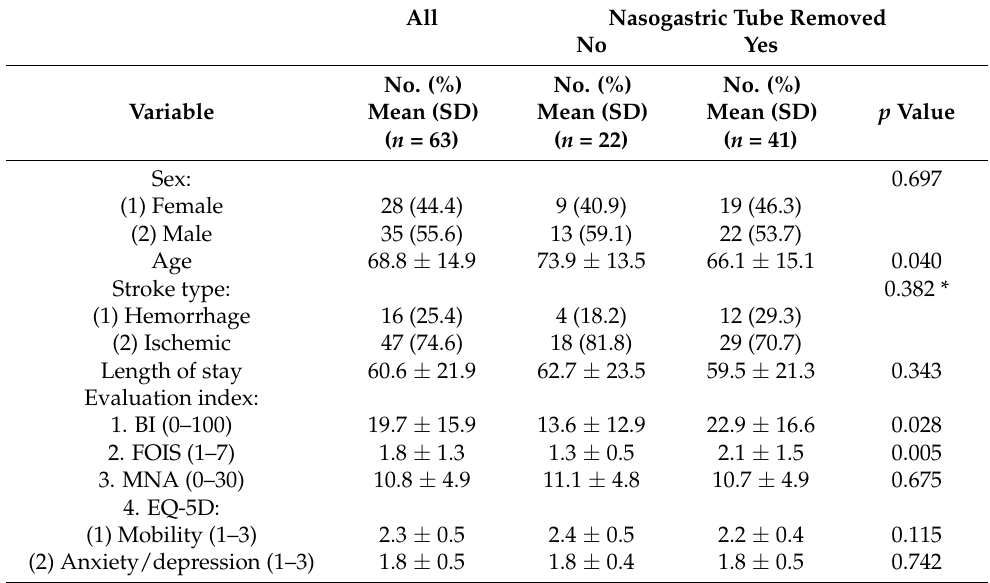
Table 1. Baseline characteristics of post-stroke